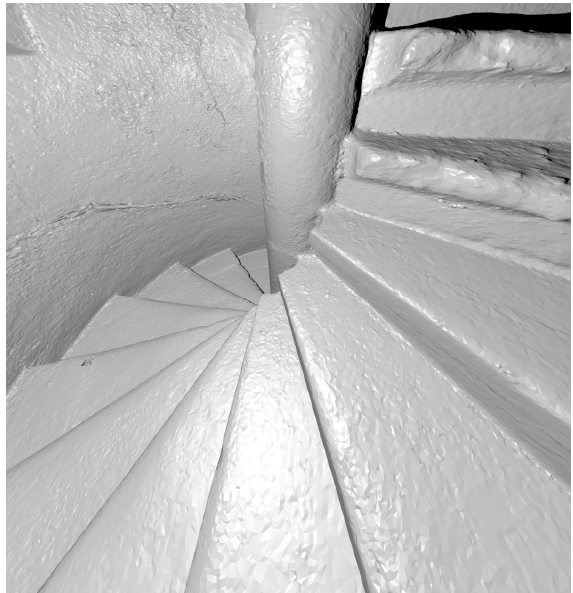
Figure 11. Rendered model of the staircase interior